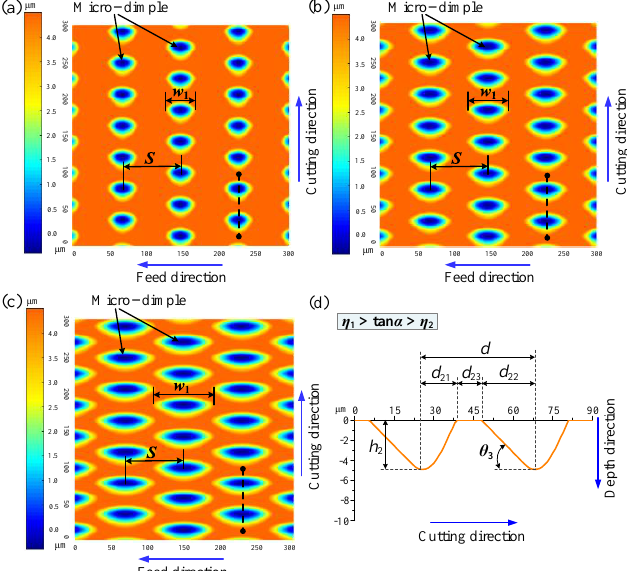
Figure 20. Simulated surface topographies and dimple profiles under processing parameters of f us = 19,670 Hz, A = 3. 9 μ m, R = 20 mm, DOC = 1 μ m, n = 400 r/min, f = 8 0 μ m/rev, α = 15°. ( a ) R c = 5 0 μ m; ( b ) R c = 10 0 μ m; ( c ) R c = 20 0 μ m; ( d ) R c = 50, 100, and 20 0 μ m.